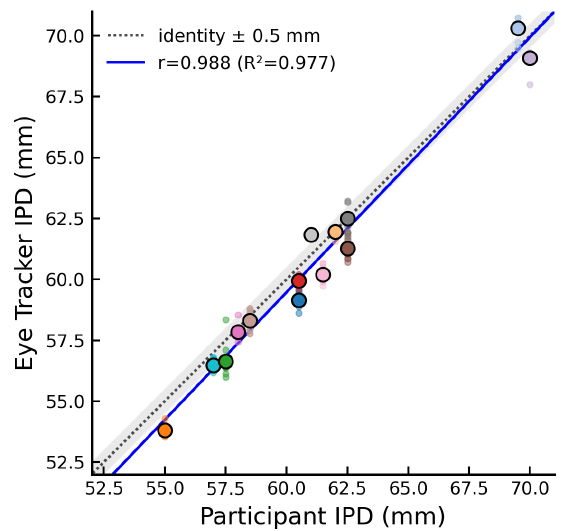
Figure 8. Participants’ inter-pupillary distance (IPD) estimated using eye tracker data, plotted as a function of true optometric IPD measured using a pupilometer. Small markers represent separate measurement sessions, large markers indicate average estimated IPD (used for regression analysis). Note that optomet- ric data was only available for fourteen participants, as it was recorded after the study was